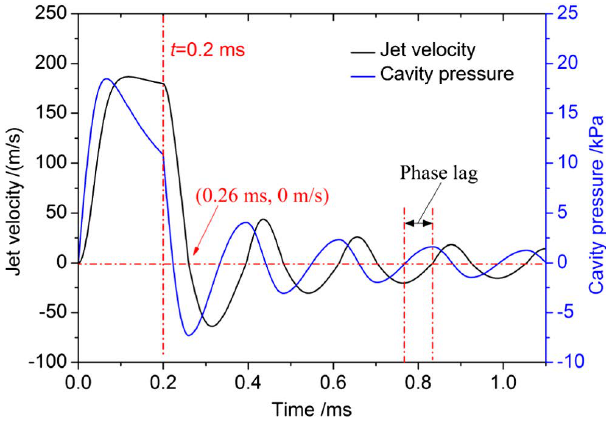
Figure 1. Evolutions of jet velocity and cavity pressure [28].